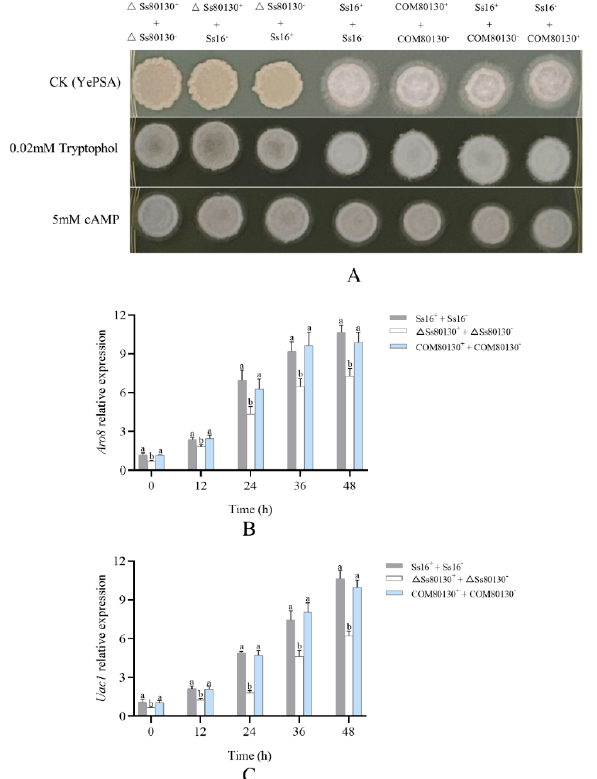
Figure 4. Effects of the SsCI80130 gene on the sexual mating of S. scitamineum. ( A ) Sexual mating ability was assessed on YePSA plates supplemented with cAMP (5 mM) or tryptophol (0.02 mM). Photographs were taken 42 h after inoculation and the control was untreated YePSA plates. ( B ) The expression level of the Aro8 gene. ( C ) The expression level of the Uac1 gene. Bars indicate the standard error and different lowercase letters represent a difference at the 0.05 level.